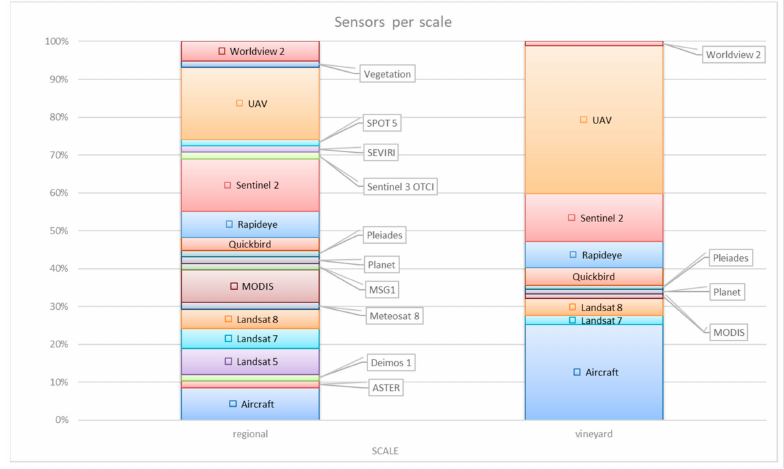
Figure 7. Percentage of sensors usage in different